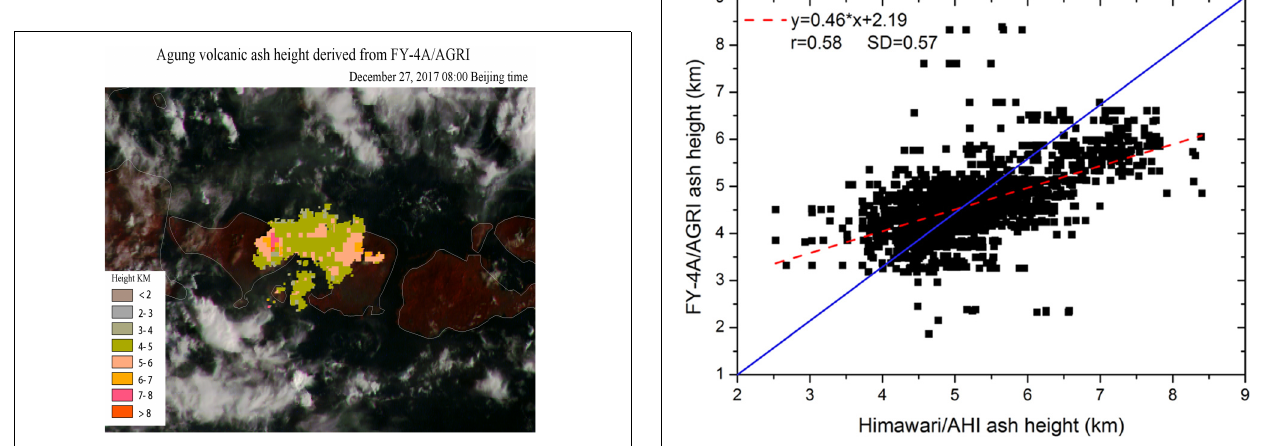
FIGURE 6 | Comparison of volcanic ash height derived from FY-4A/AGRI and Himawari/AHI.